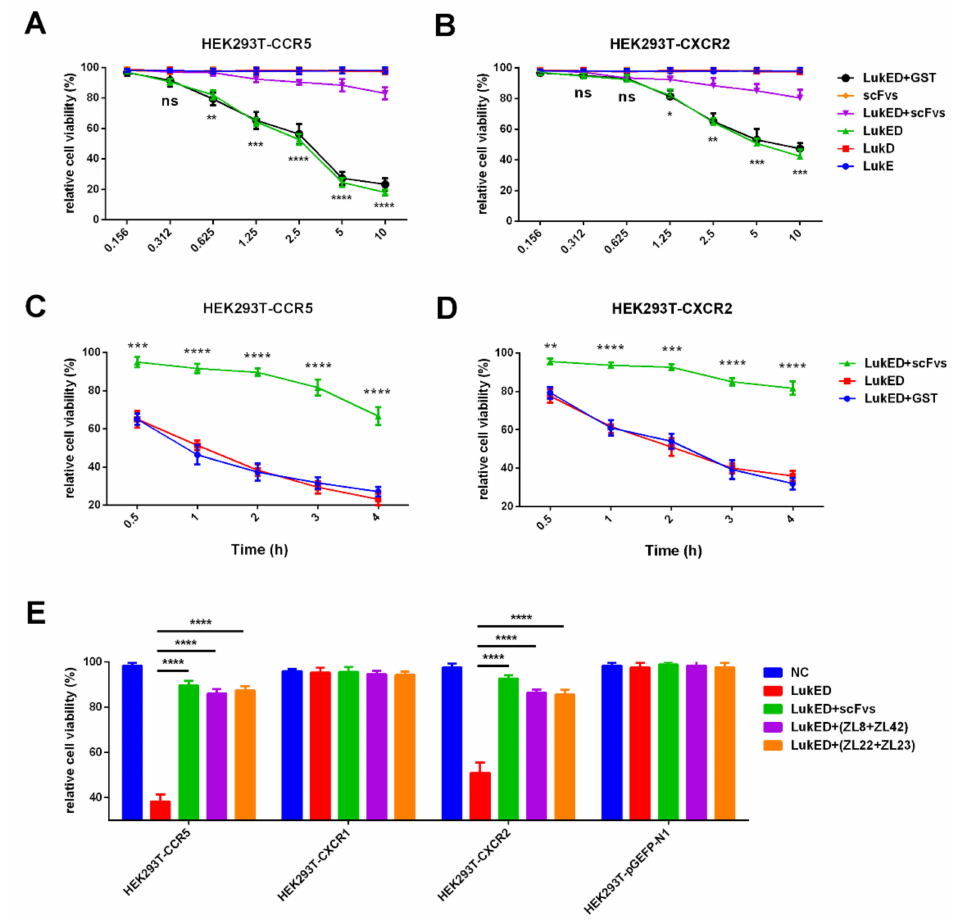
Figure 3. The protective effect of scFvs on the cell killing of HEK293T cells containing CCR5 and CXCR2 caused by LukED. ( A , B ) The cell killing of HEK293T cells containing CCR5 and CXCR2 upon incubation with the scFvs mixture and different concentrations of LukED. ( C , D ) The cell killing of HEK293T cells containing CCR5 and CXCR2 upon incubation with LukED and the scFvs mixture over time. ( E ) The effect of scFvs on the rise of the relative cell viability of LukED-mediated HEK293T cells by blocking the binding of LukED with CCR5 and CXCR2. * p , ** p , *** p , **** p vs. the NC group (LukED group). Data represent the mean results ± SD ( n = 3) (ns = p > 0.05, * p < 0.05, ** p < 0.01, *** p < 0.001, **** p <